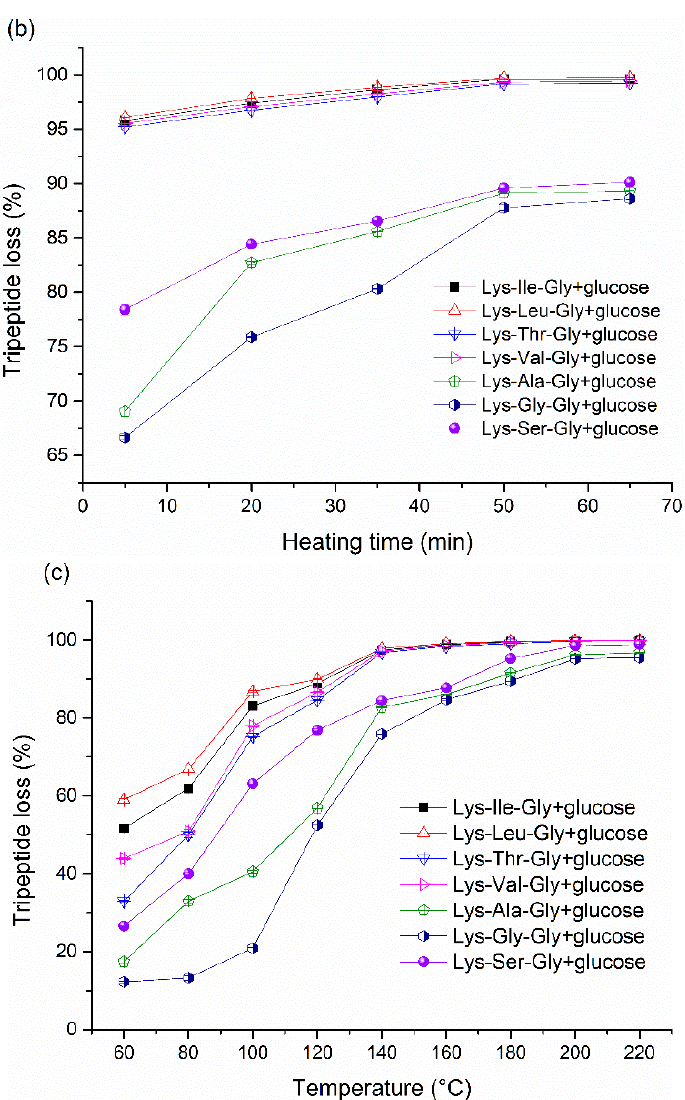
Figure 4. Peptide loss in the heat-treated tripeptide-glucose mixtures, ( a ) tripeptide-glucose mixtures at different initial molar ratios, time 20 min, temperature 140 °C; ( b ) tripeptide-glucose mixtures at various heat-treated times, initial molar ratio 1:1, temperature 140 °C; ( c ) tripeptide-glucose mixtures at different heating temperatures, initial molar ratio 1:1, time 20 min.